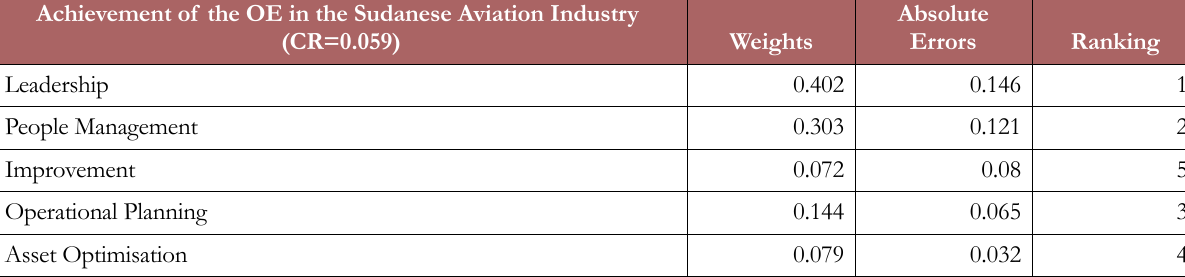
Table 4. Normalised Local Weights of Judgment and Ranking for